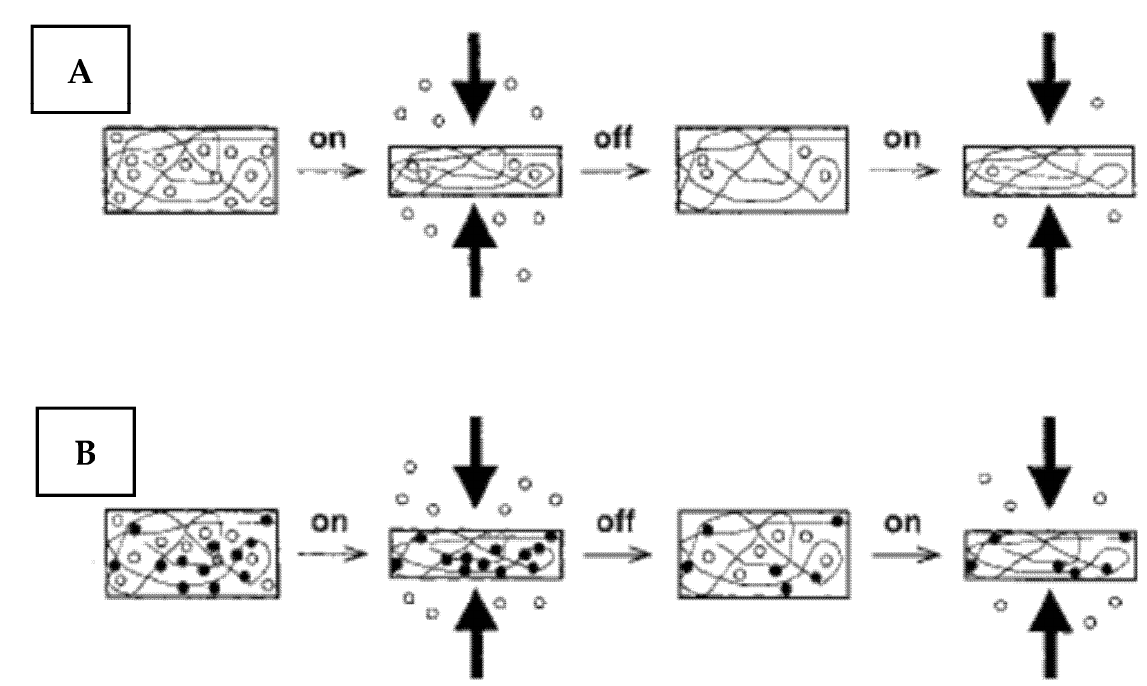
Figure 15. A scheme of anticipated drug release from polymeric matrices under mechanical signaling. ( A ) Expected release behavior of the drug that does not strongly interact with the matrix. ( B ) Proposed release behavior of the drug that interacts with the matrix (white circle—free drug; black circle—bound drug). Reprinted with permission from ref. [163]. Copyright 2012 Wiley.